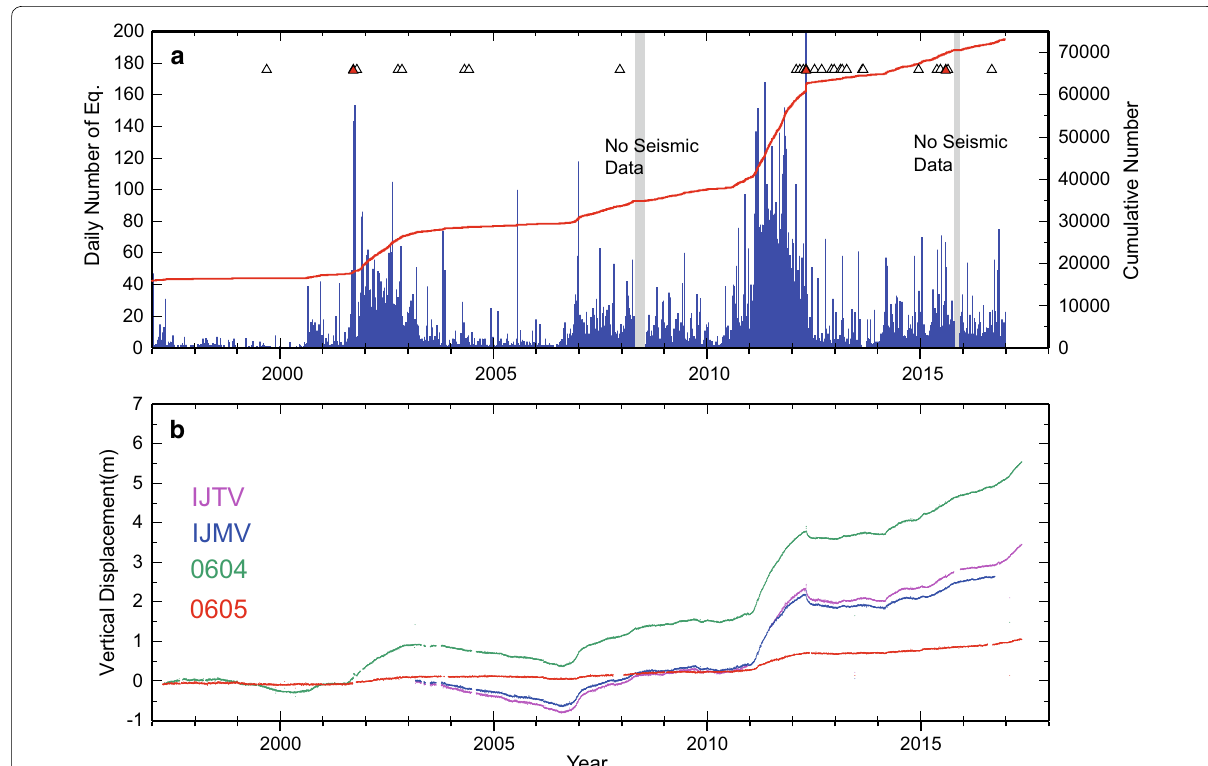
Fig. 3 A comparison between earthquake activity and vertical movement of Ioto after 1997. a Daily number of earthquakes counted at IJMV. The red curve shows the cumulative number of earthquakes. The red triangles and white triangles denote occurrence times of phreatic eruptions with and without precursors, respectively. b Vertical movement by daily solutions of continuous GNSS observation after 1997 at the continuous